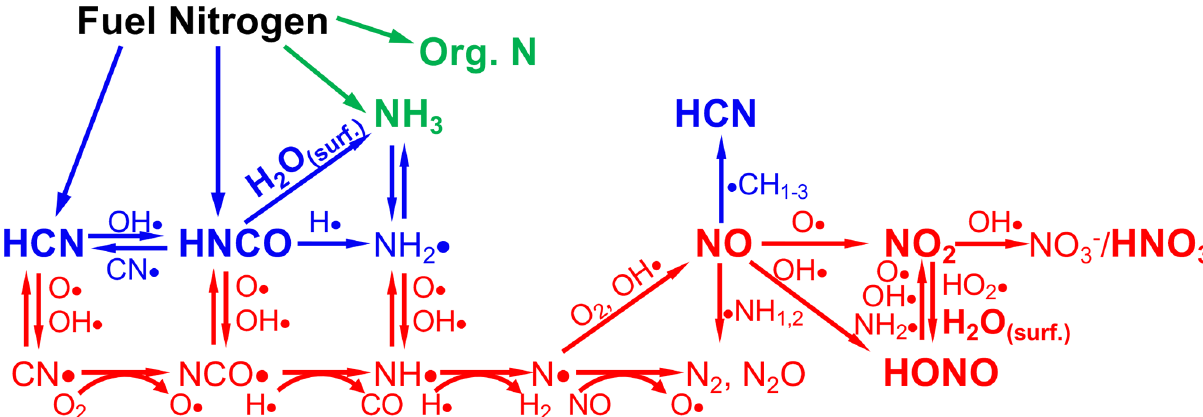
Figure 1. Schematic of the combustion chemistry of the small molecules that are emitted from BB and represent sources and sinks of reactive nitrogen (N r ), adapted from Glarborg et al. (2018), Lobert and Warnatz (1993), Lucassen et al. (2012), and Manion et al. (2015). H 2 O ( surf ) denotes the combination of H 2 O and a surface to facilitate the reaction. Red color indicates the highest temperature (combustion) processes; blue indicates intermediate temperature processes, and green indicates the lowest temperature processes. The species that are measured in this work are shown in bold and slightly larger